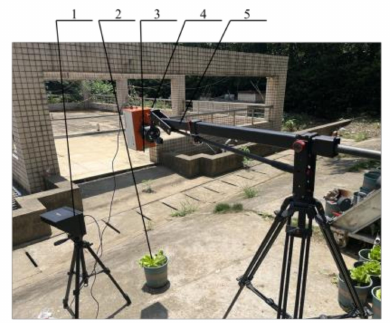
Figure 2. Outdoor hyperspectral imaging system. 1. Monitor. 2. Lettuce sample. 3. Sensor probe. 4. Hyperspectral imager. 5. Outdoor test